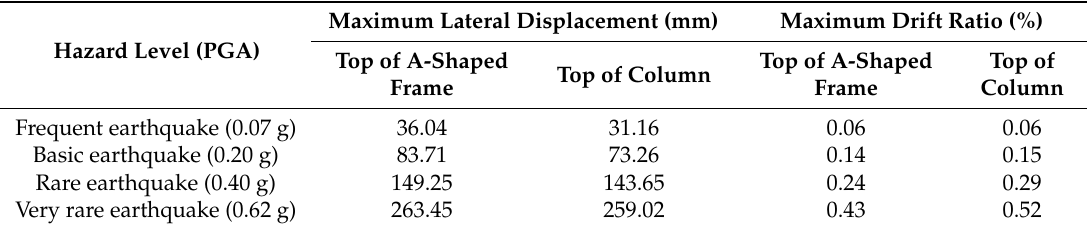
Table 4. Summary of maximum lateral displacements and drift ratios.